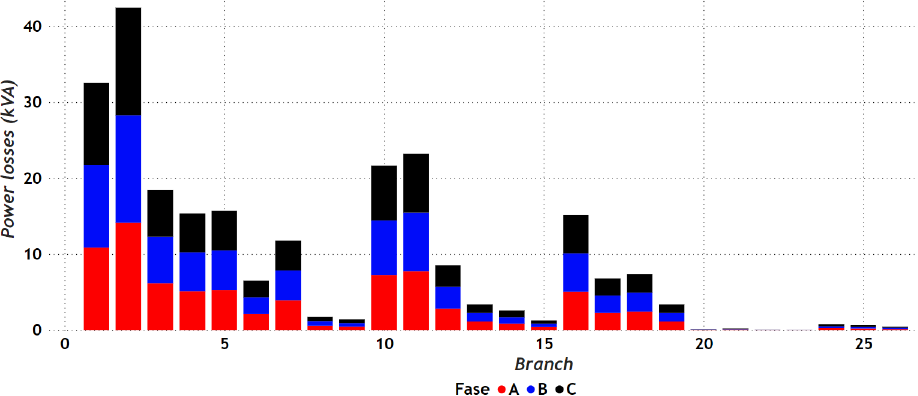
Figure 10. Power losses present in the branches of the three-phase 27-bus distribution system under a balanced load